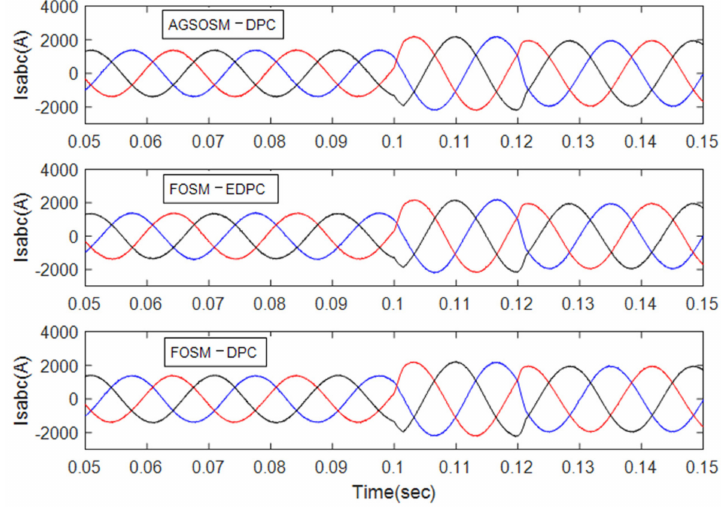
Figure 4. Stator current under balanced grid